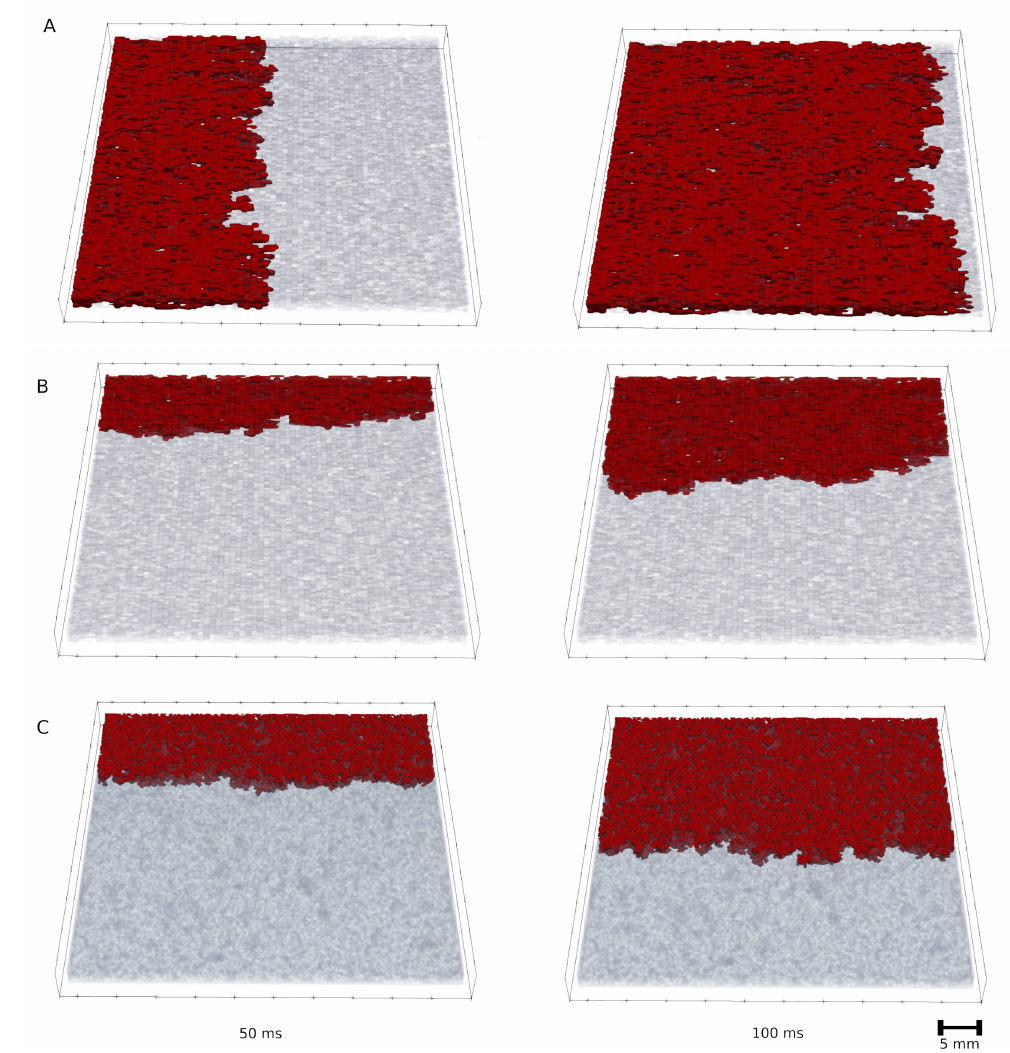
Figure 3. Electrical wave propagation in models with structural (panels A , B ) and diffuse (panel C ) fibrosis. Panels A , B show a myocardial slab with elongated fibrosis texture of linear 3 × 1 × 1 elements of 3 x -node length. Wave propagation in the 3D myocardial slab was initiated on the left lateral surface of the cuboid for the longitudinal propagation (panel A ) and on the upper lateral surface for the transversal propagation (panel B ). The red color shows activated cells, the gray color indicates non-activated cells and transparent cells within the gray zone indicates fibrosis. Fibrosis density is 60%. Snapshots of excitation propagation are shown at 50 (left panels) and 100 ms (right panels) after excitation onset. The figure illustrates faster excitation propagation for the wavefront co-directed along the elongation of the fibrosis elements. In this case (panel A , longitudinal wavefront), about two times larger part of the myocardial volume is activated at the certain time moments as compared to the wave propagation across the fibrosis elongation (panel B , transversal wavefront). Panel C shows wave propagation in the model with 60% diffuse fibrosis. Here, excitation wave is initiated at the upper surface, and is independent of the wavefront direction. The conduction velocity at diffuse fibrosis is much slower than that at the longitudinal wavefront direction for the elongated obstacles, and is near to that for the transversal wavefront direction (CV = 0.29 mm/ms in panel C versus 0.48 mm/ms in panel A , and 0.24 mm/ms in panel B